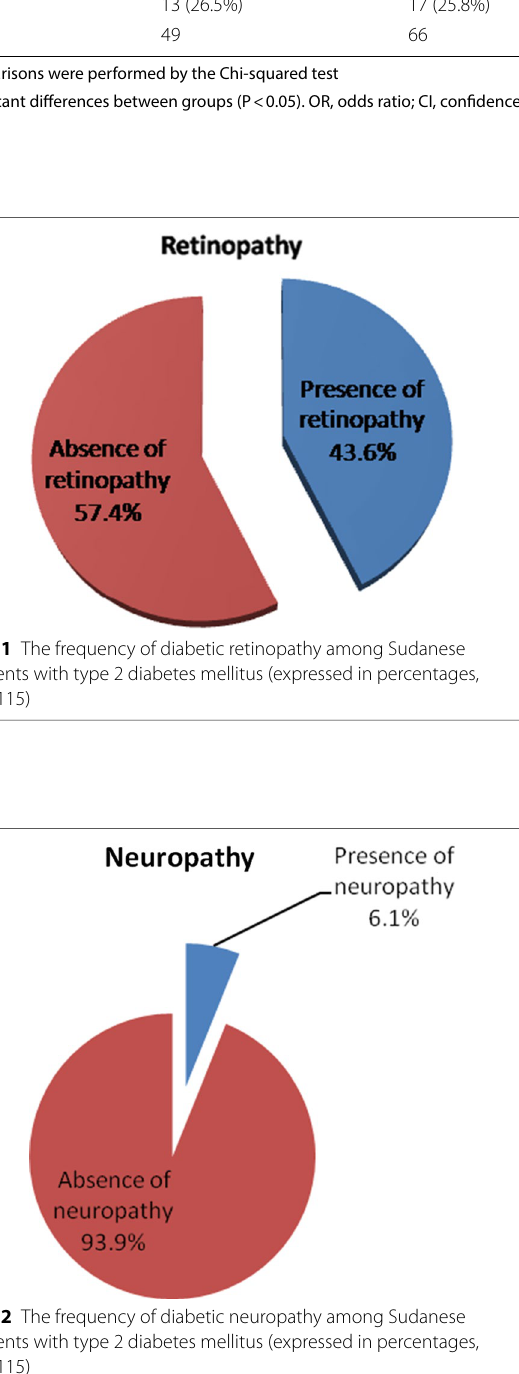
Comparisons were performed by the Chi-squared test Significant differences between groups (P < 0.05). OR, odds ratio; CI, confidence interval